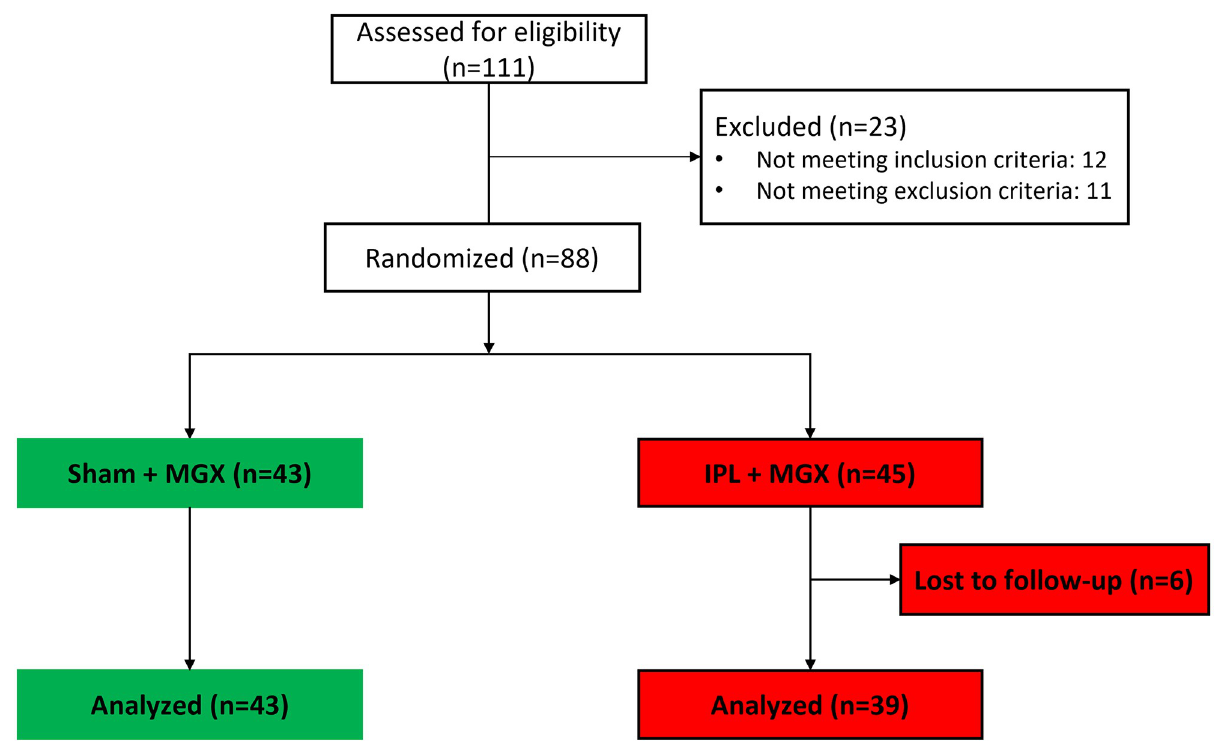
Fig 1. Flow diagram. n: number of